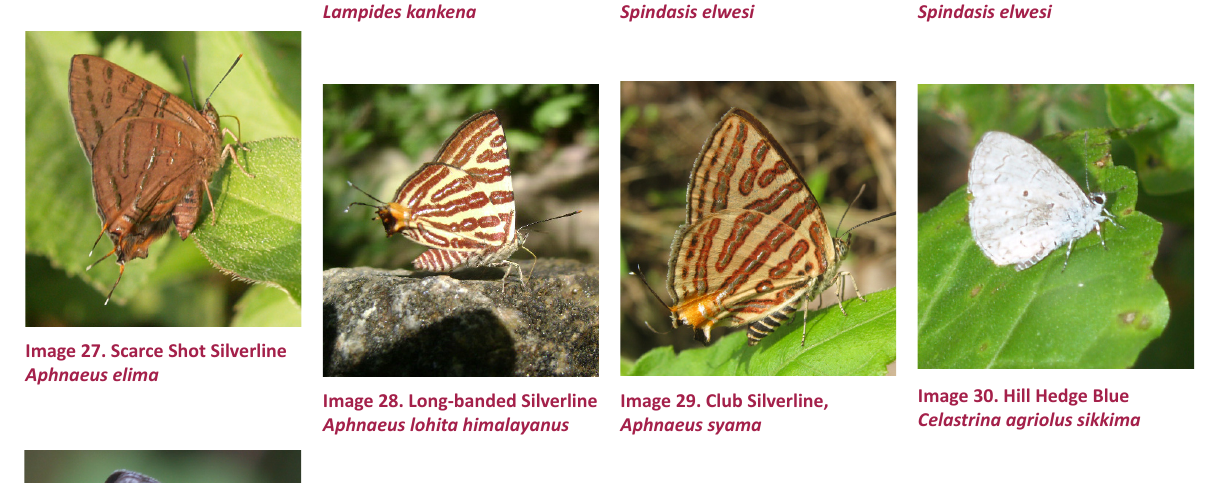
Image 25. Elwes Silverline Spindasis elwesi